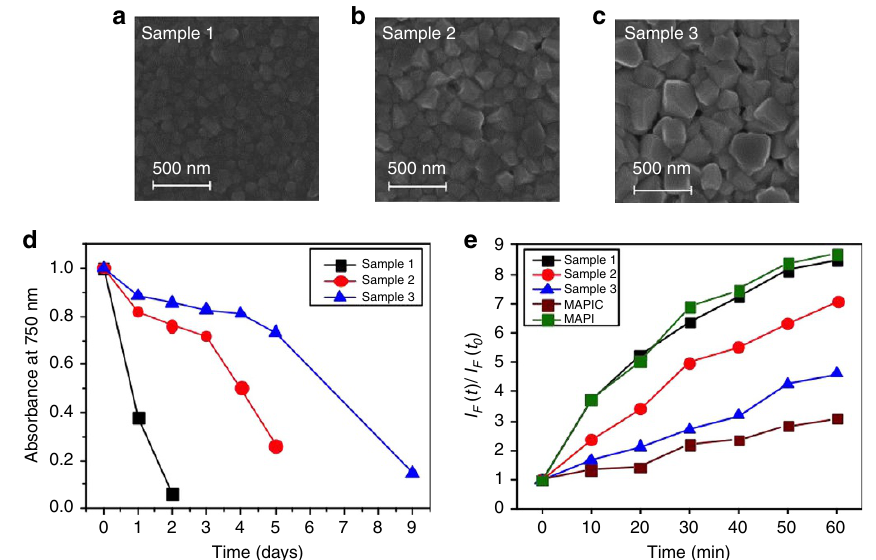
Figure 4 | Particle size effects. ( a – c ) Surface SEM images of small (sample 1), medium (sample 2) and large (sample 3) crystal sizes of CH 3 NH 3 PbI 3 . ( d ) Normalized absorbance decay at 750nm for methylammonium lead iodide of sample 1 (small crystals, 100nm), sample 2 (medium crystals, 150nm) and sample 3 (large crystals, 250nm) with degradation conditions of illumination (25mWcm (cid:2) 2 ) and dry air. ( e ) Superoxide yield plot for CH 3 NH 3 PbI 3 (with small (black), medium (red), large (blue) crystal sizes and a toluene dripped prepared sample (green) and CH 3 NH 3 PbI 3 (Cl)